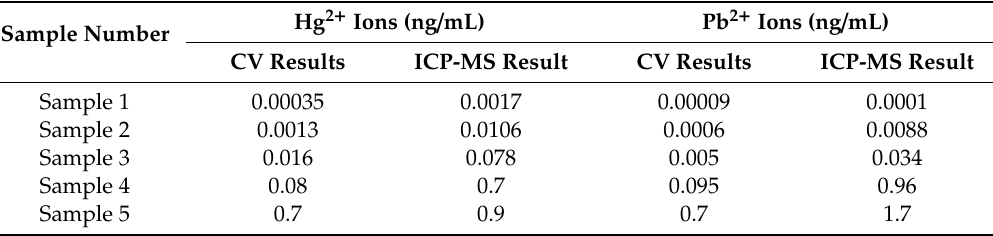
Table 1. ICP-MS testing results of real